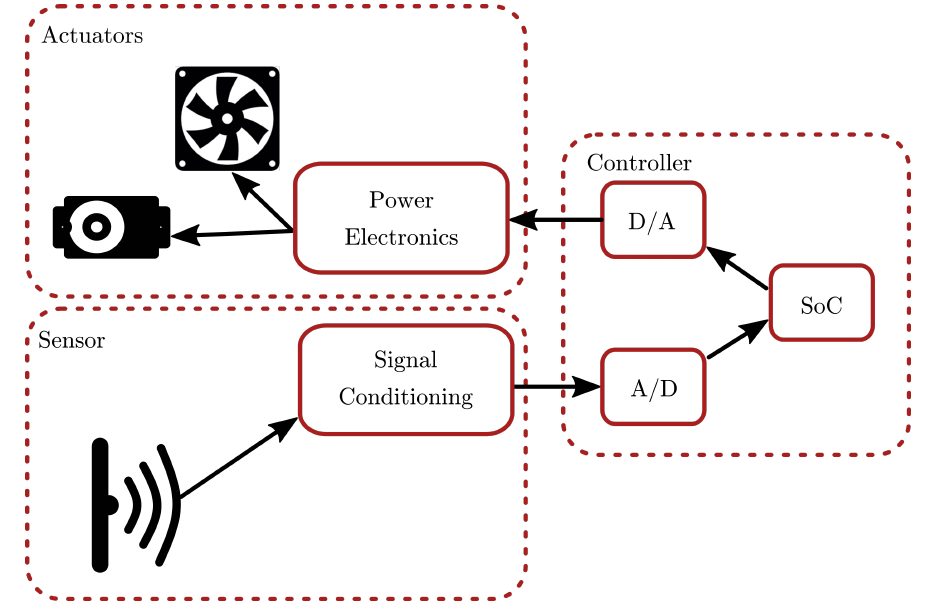
Figure 2. Schematic view of the air levitation control